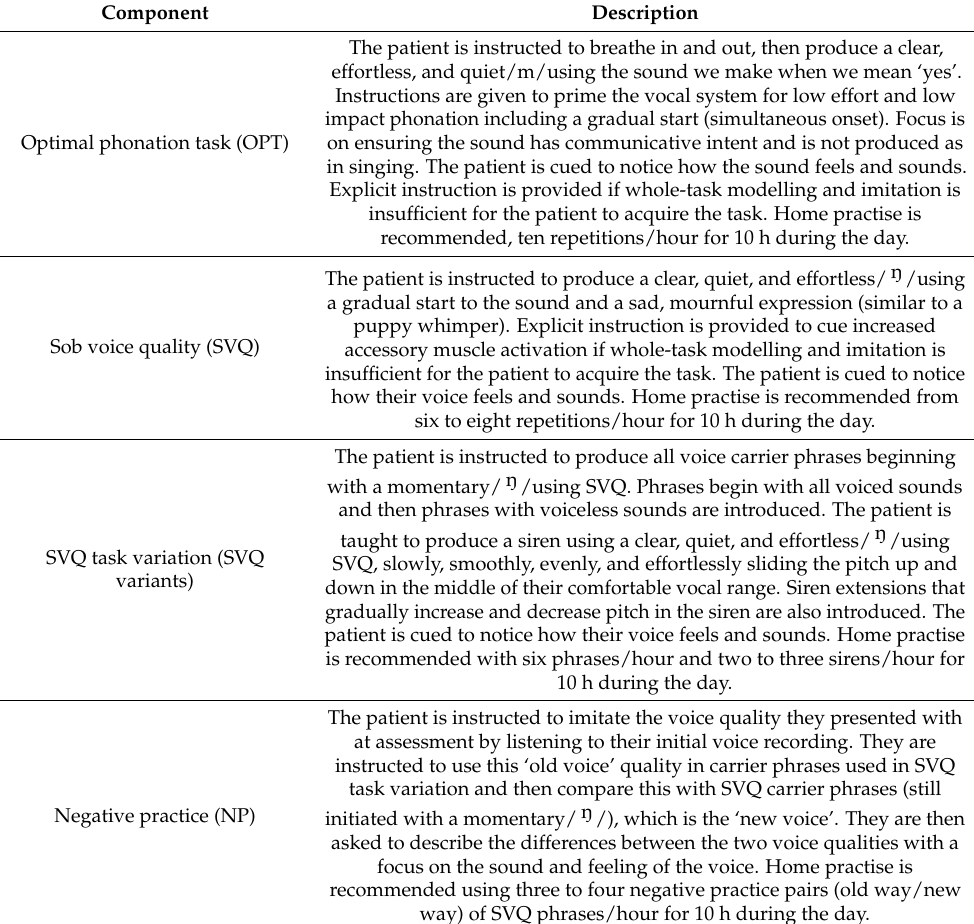
Table 1. Name and brief description of each of the first four Sob Voice Therapy